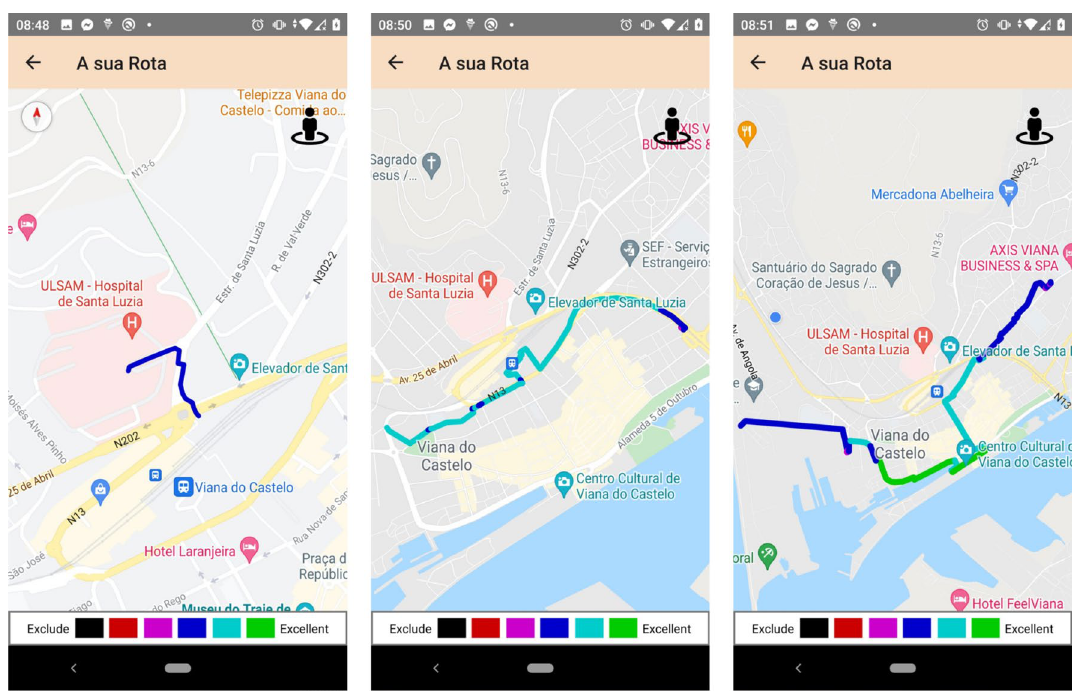
Fig. 4 Optimised paths S1, M1, and